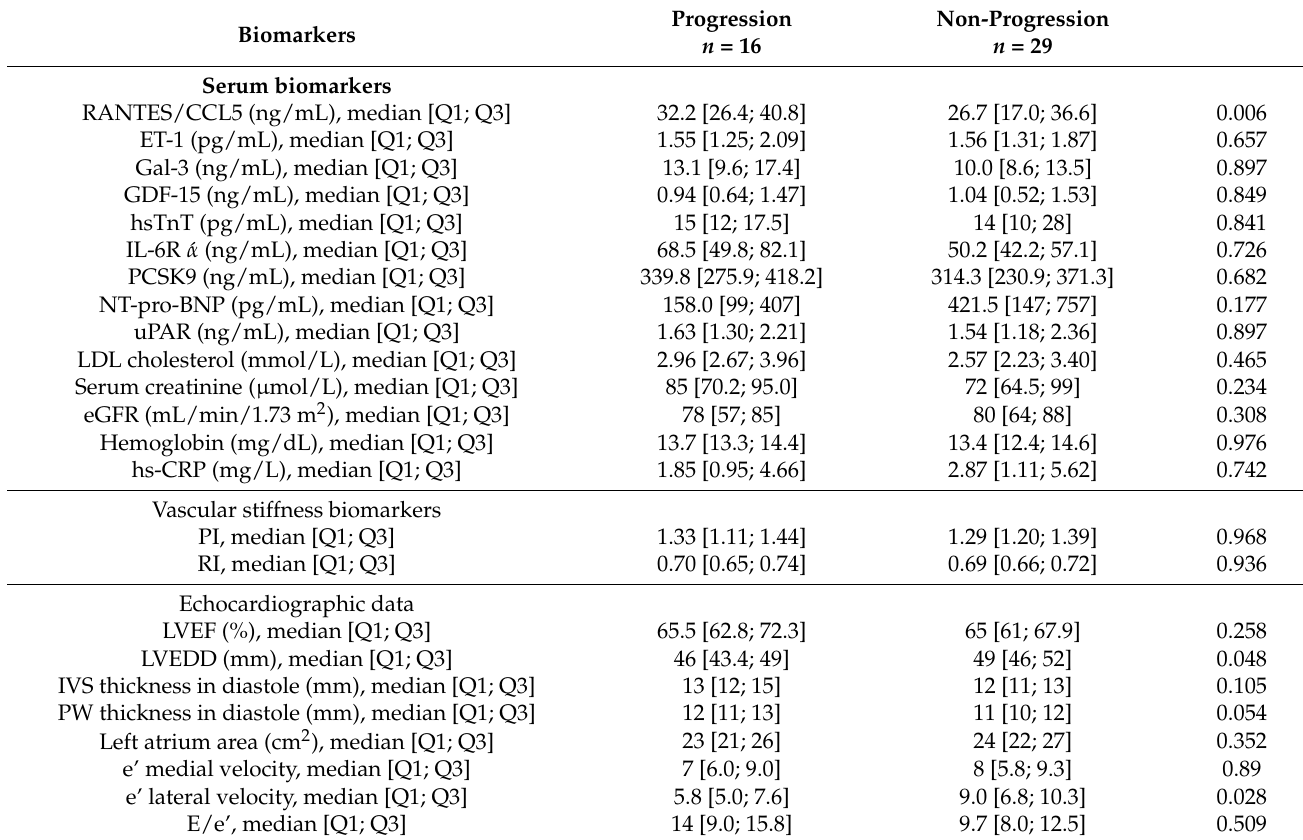
Table 2. Biomarkers associated with progression to severe